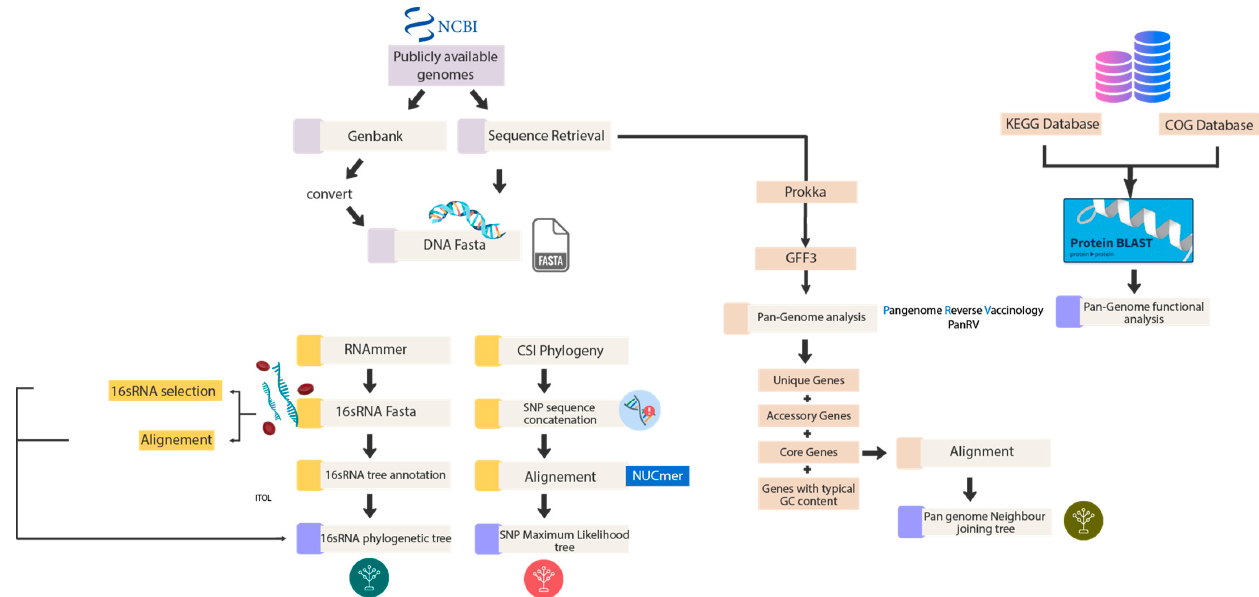
Figure 2. Phylogenetic analysis. The flowchart demonstrates the first component of the methodology, the phylogenetic analysis, outlining the software in detail.